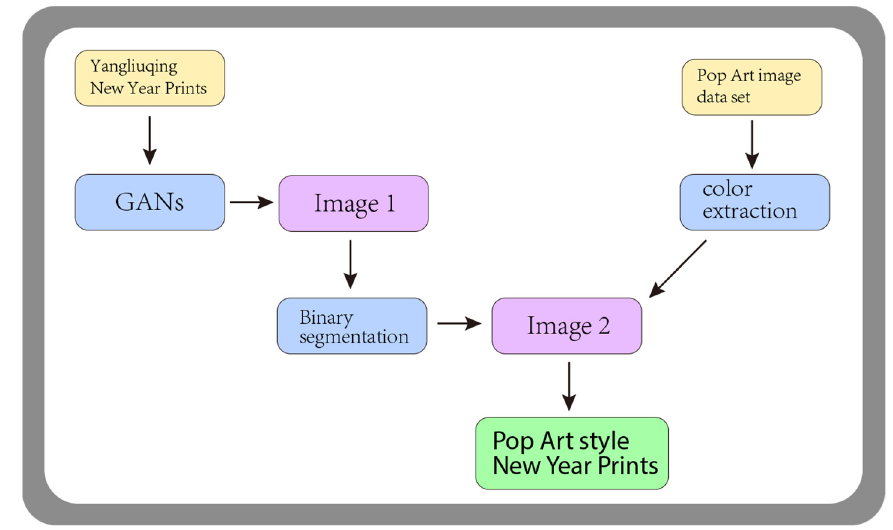
Figure 4. Pop art style image.